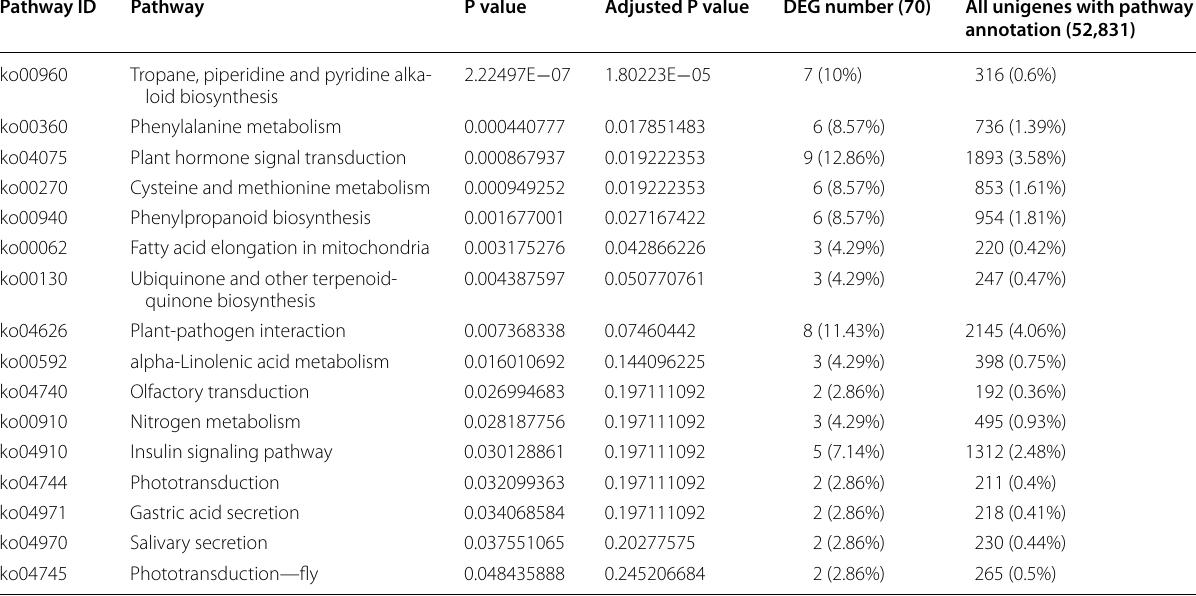
Table 3 The significantly enriched KEGG pathways for DEGs across the three cDNA libraries Pathway ID